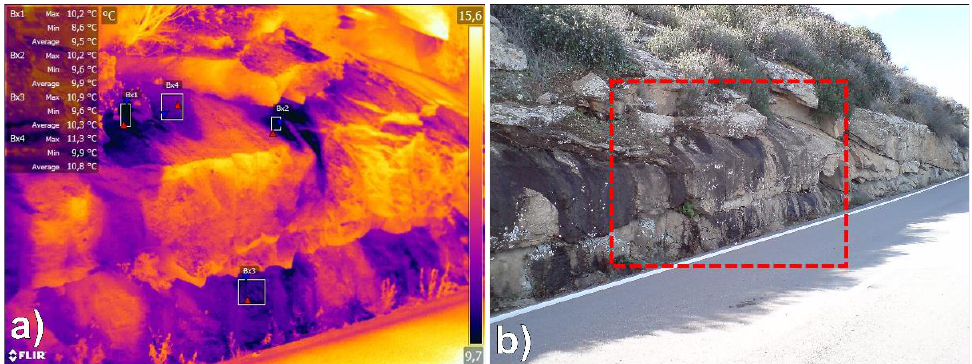
Figure 6. Rock mass IRT survey (colorbar “iron”). Cold thermal anomalies in correspondence of granite exfoliation joints ( a ); correspondent visible image ( b ) (red dashed square highlight the camera field of view).